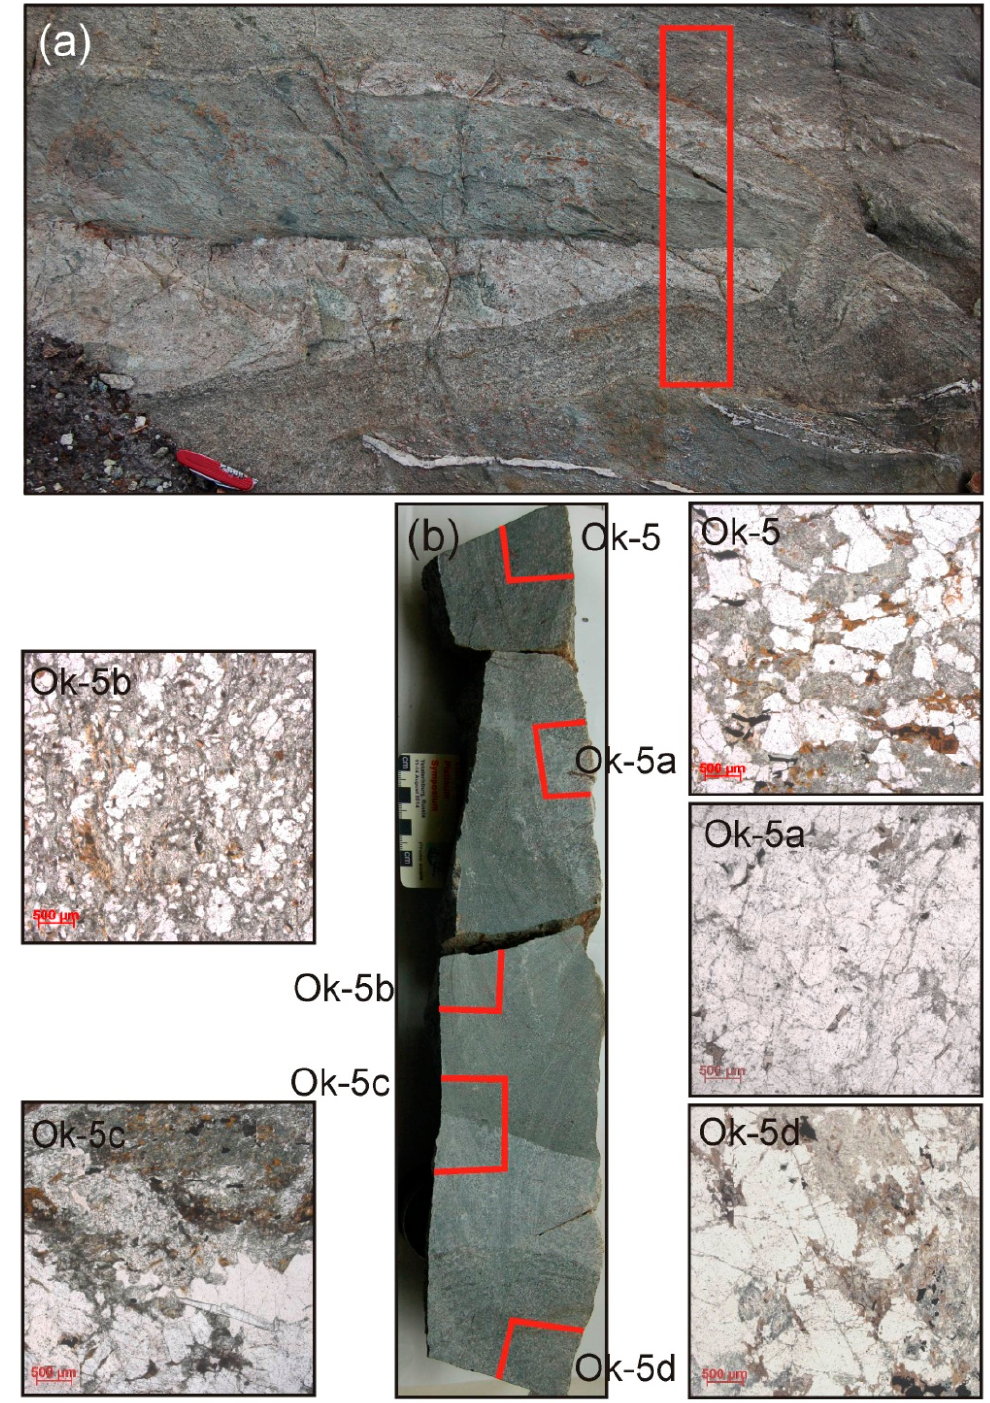
Figure 4. Boudins and leucocratic gneiss lenses among melanocratic rocks. ( a ) Outcrop, the red rectangle shows the contour where the sample shown in ( b ) was cut. The red lines in ( b ) show the sections of the sample from which transparent thin sections were made. Corresponding photos in plane polarized light are shown on fragments OK-5–OK-5d.